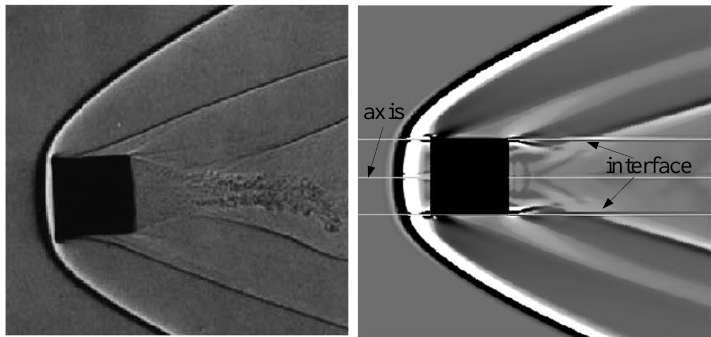
Figure 6. Comparison of numerical and experimental results in the projectile flight experiment.